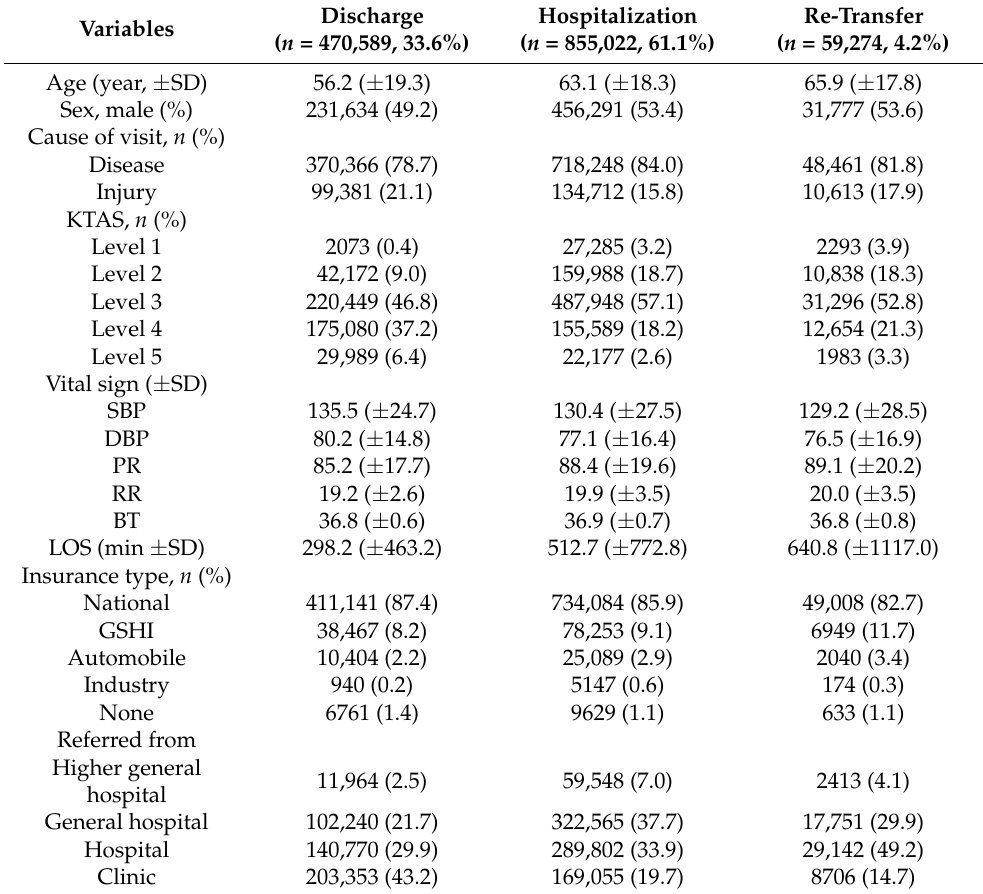
Table 2. Clinical characteristics based on the patient dispositions in referred